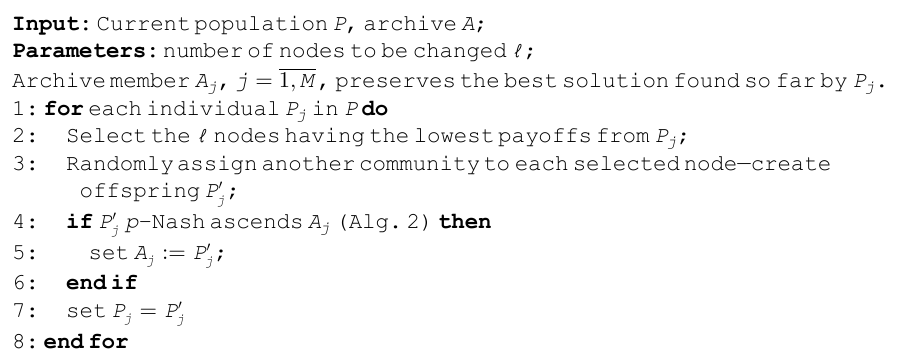
Algorithm 1 The Extremal Optimization